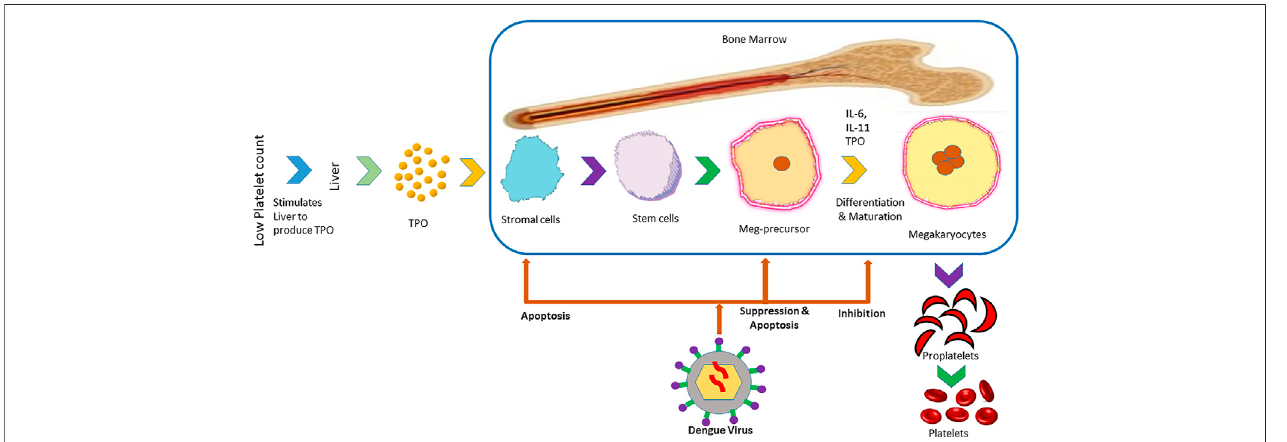
FIGURE2| Mechanismofinhibitionoftheformationofplateletsinbonemarrowbydenguevirus.Thepanelillustratesthestepsintheformationofplateletsfromthe liver that is stimulated by low platelet count in the blood. After the infection of the host with dengue virus, it prevents the formation of platelets from stromal cells and maturation in different stages.